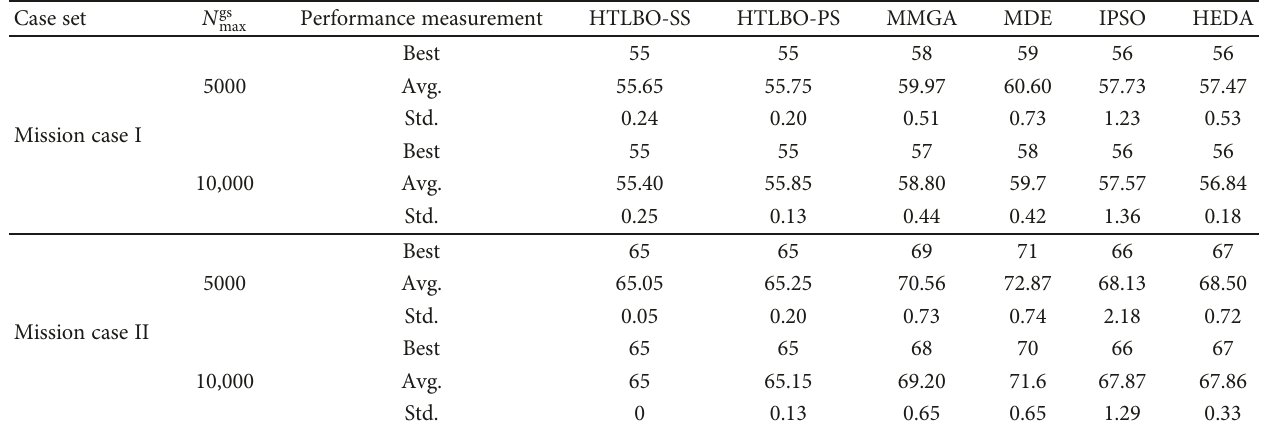
Table 11: Result comparison between TLBO and published algorithms (deterministic